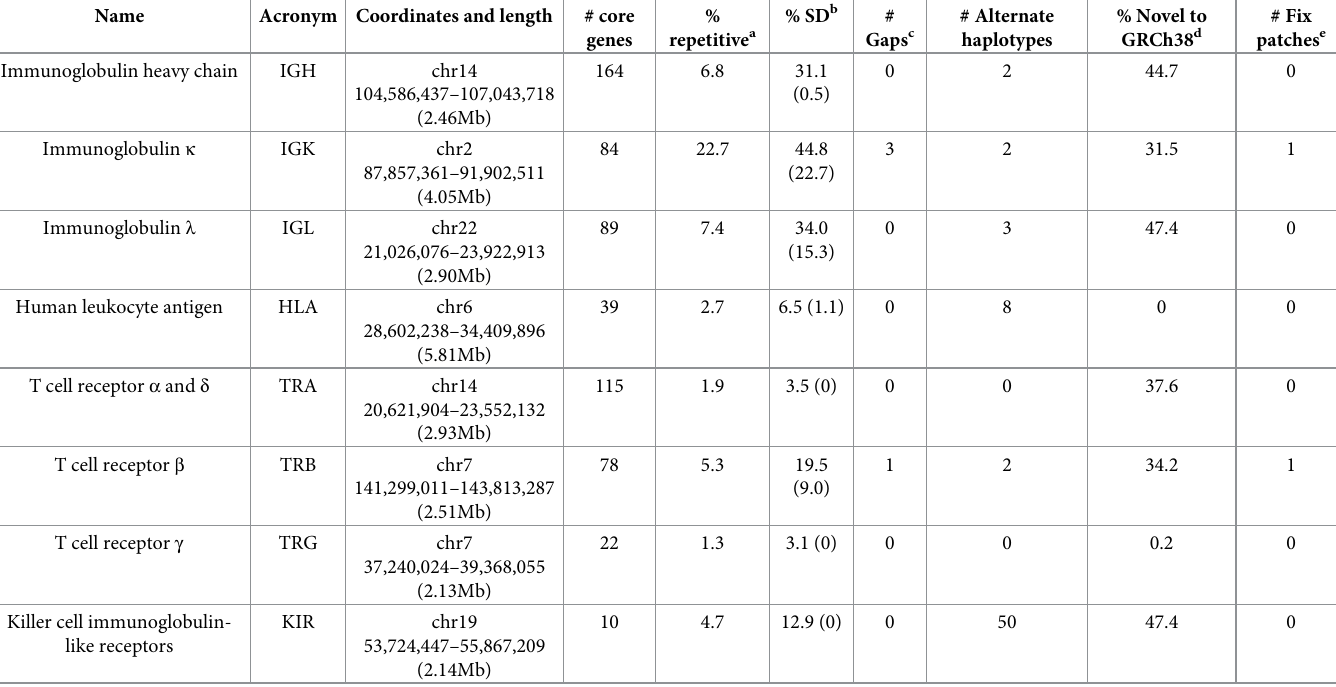
Table 1. Overview of eight selected immune system loci in GRCh38.